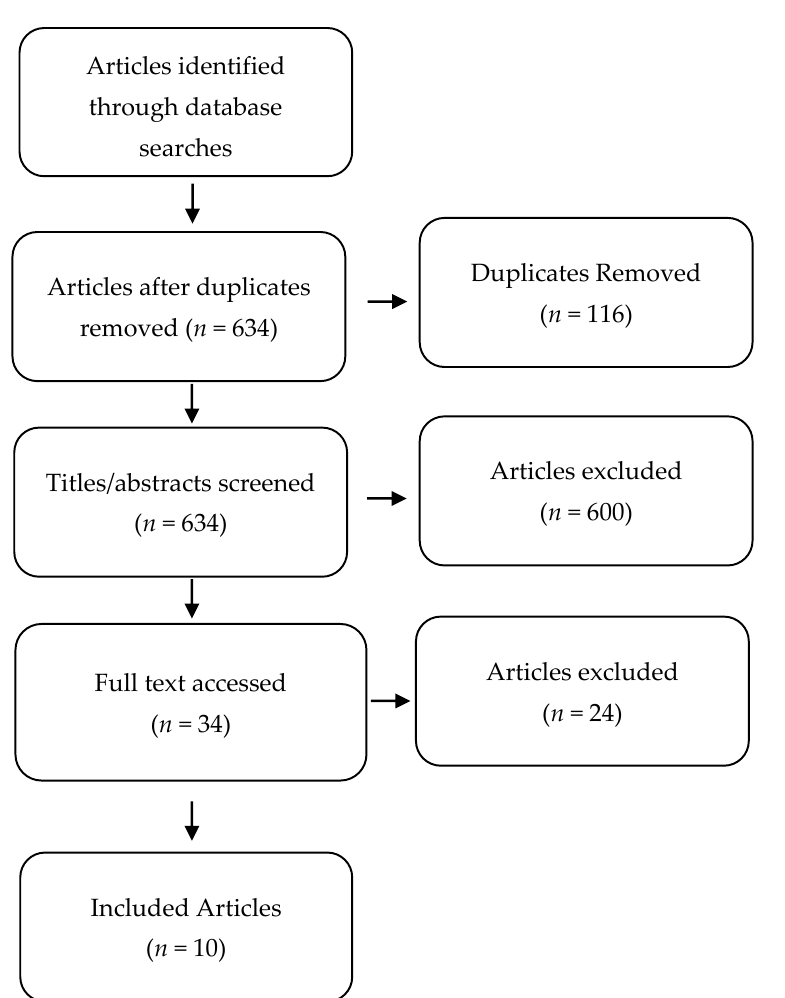
Figure 1. Flow diagram outlining selection of studies based on PRISMA guidelines.